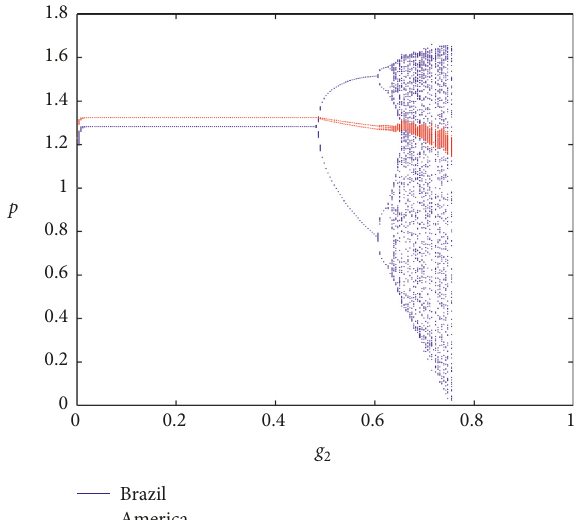
Figure 2: The tracks of p